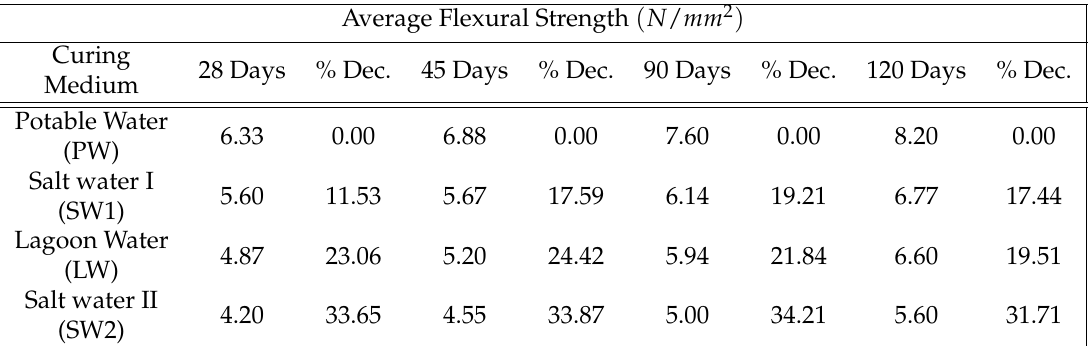
Table 5. Effect of different curing medium on flexural strength of concrete Average Flexural Strength ( N / mm 2